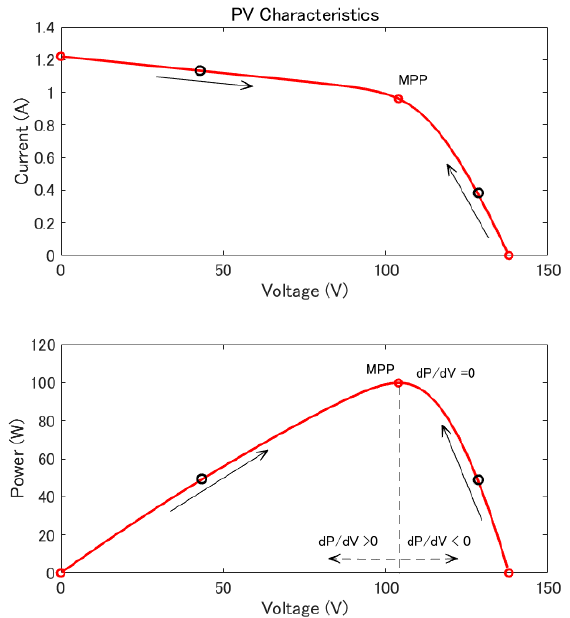
Figure 6. Characteristic PV and MPPT control